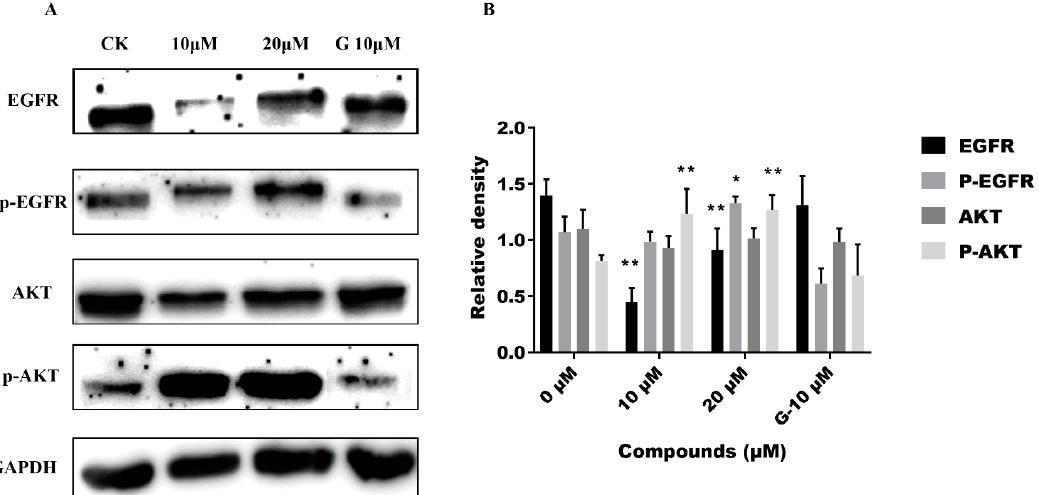
Figure 6. The effect of 5i on EGFR protein kinase signal pathway. ( A ) A549 cells were incubated with 5i of different concentrations for 48 h. Gefitinib with a concentration of 10 μ M was used as positive control (G-10 μ M). Expressions of EGFR, P-EGFR, Akt, and P-Akt were detected by Western blot. ( B ) Quantify the relative protein expression levels of EGFR, P-EGFR, Akt, and P-Akt. GAPDH is used for load control. The values are expressed as mean SD from three individual experiments. * Statistically significant ( p < 0.05). ** Statistically extremely significant ( p < 0.01).